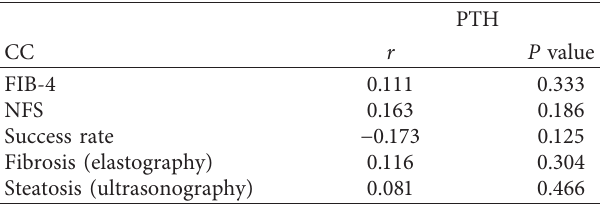
Table 4: Relationship between baseline PTH and liver status after bariatric